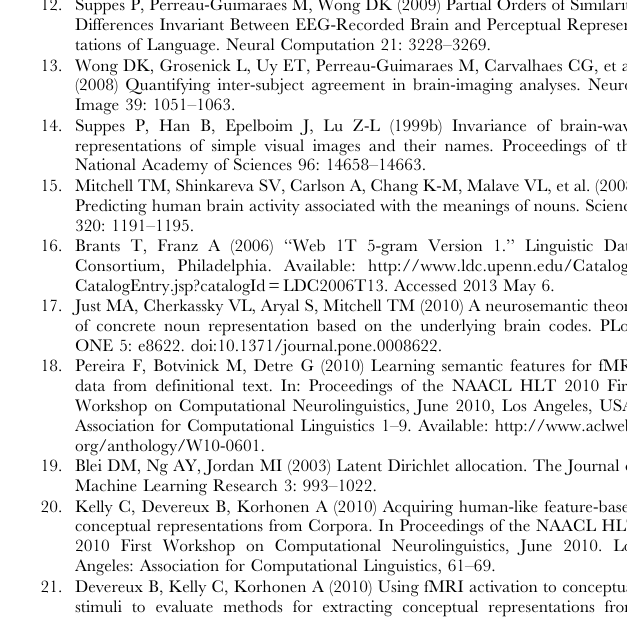
Figure S1 a 2 j: WordNet-based and LSA-based semantic similarities and brain conditional probability estimates for (a) London ; (b) Moscow ; (c) Paris ; (d) north ; (e) south ; (f) east ; (g) west ; (h) Germany ; (i) Poland ; and (j) Russia, relative to London , Moscow , Paris , north , south , east , west , Germany , Poland , and Russia . Data taken from Figure 1, Figure 2, and Figure 4. (TIFF) Material S1 Trigger sentences and timings. Table S1: Timings for trigger sentences. Table S2: Timings for the presentation of the individual words in each of the 48 trigger